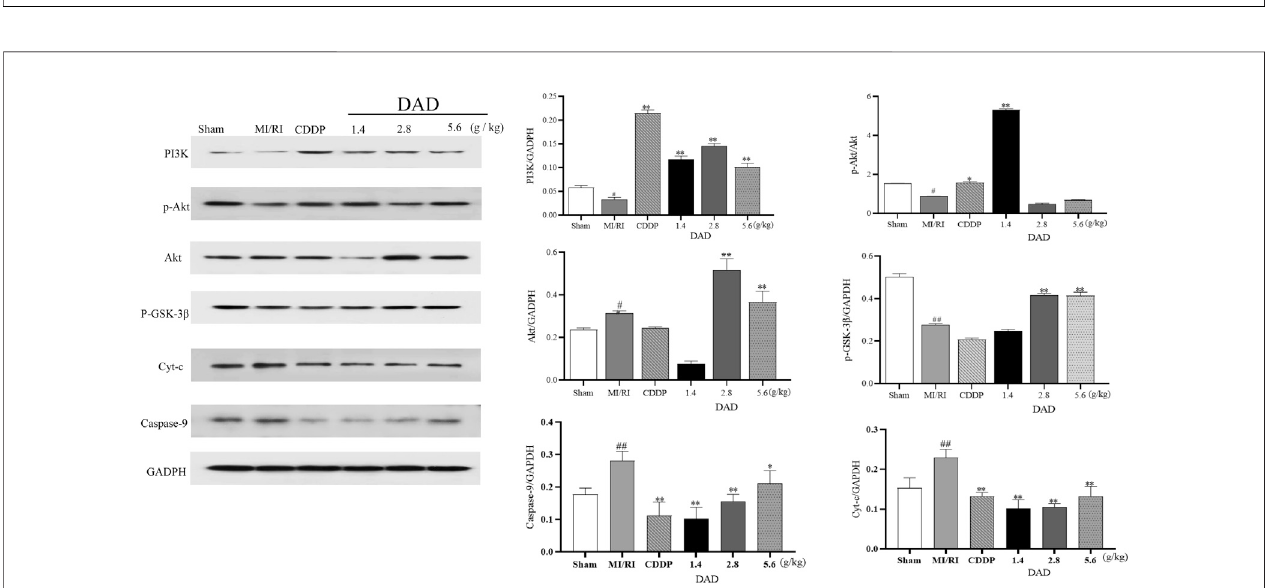
FIGURE 9 | Experimental validation of key signaling pathways and mitochondrial key targets in vivo . Dried ginger-aconite decoction(DAD) activates the PI3k/Akt/ GSK-3 β signaling pathway and inhibits the expression of Cyt-C and CASP9. Data were presented as mean standard deviation (SD) of three independent experiments. # p < 0.05, ## p < 0.01 vs. sham group. * p < 0.05, ** p < 0.01 vs. MI/RI group.